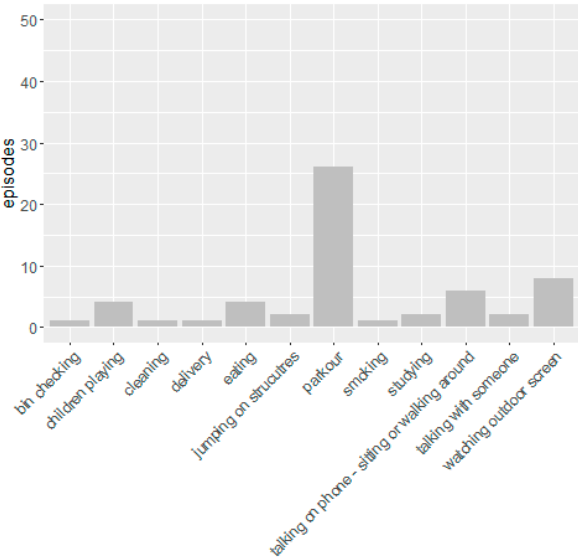
Figure 7. Types of activities observed.